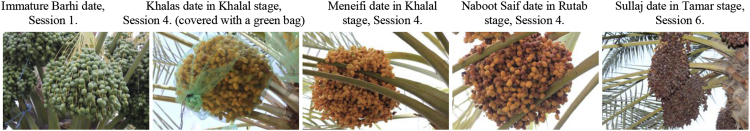
Sample images of the five date varieties in dataset-1 showing different maturity stages. Some bunches are covered with bags for their protection.